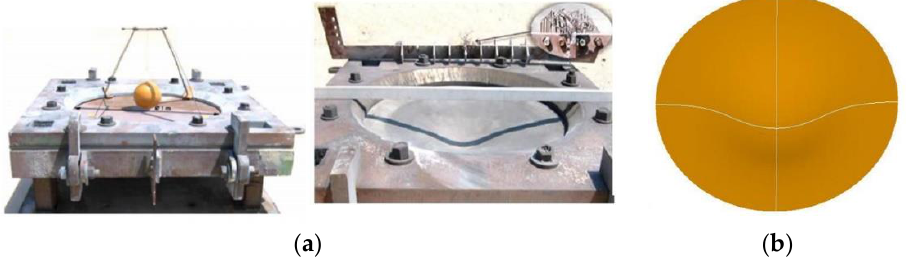
Figure 6. ( a ) Diagram of the validated test of Neuberger [44]. ( b ) Simulated deformation of [45].